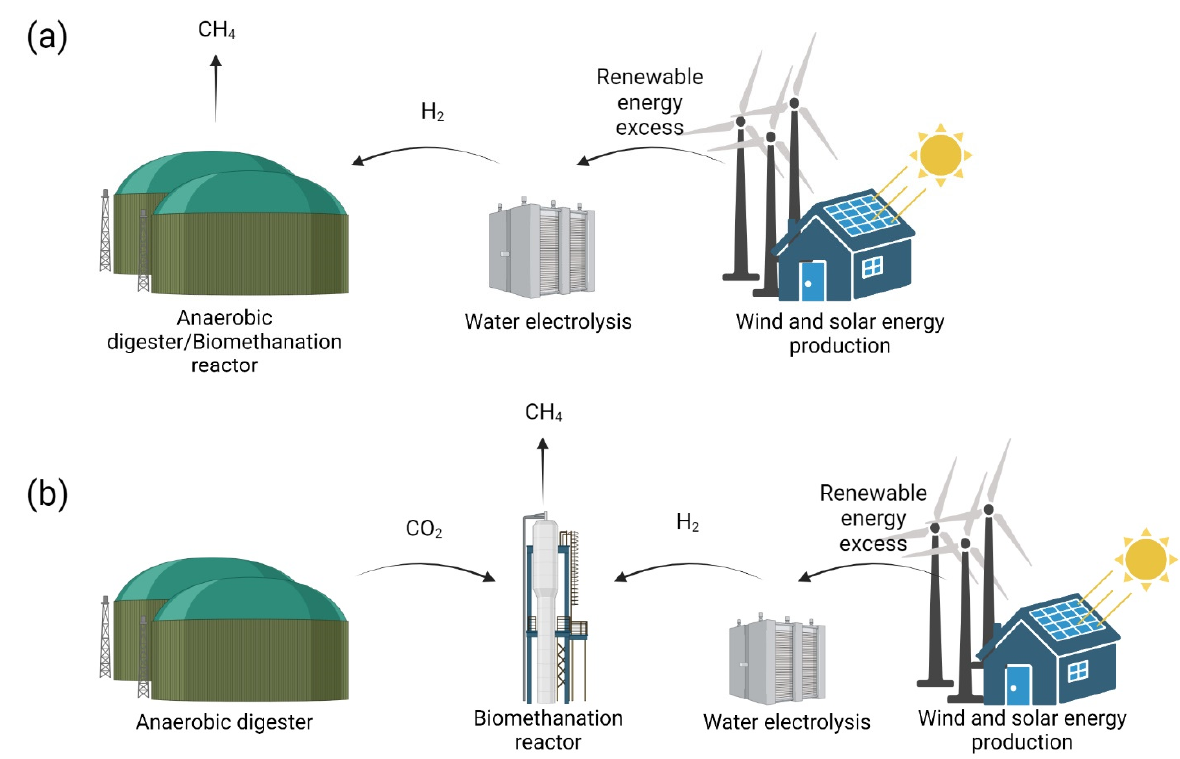
Figure 4. Scheme representing in situ ( a ) and ex situ ( b ) biomethanation technologies.